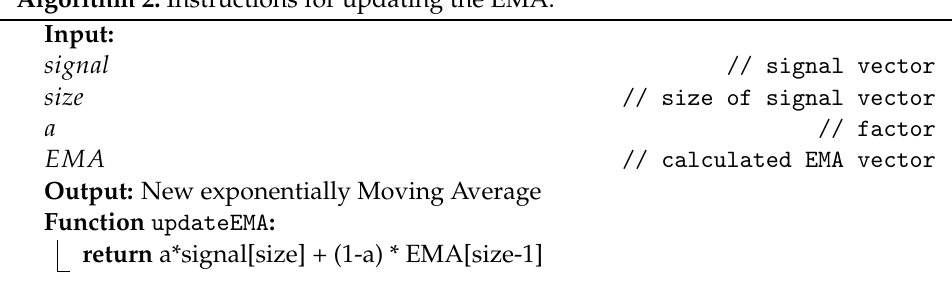
Algorithm 2: Instructions for updating the